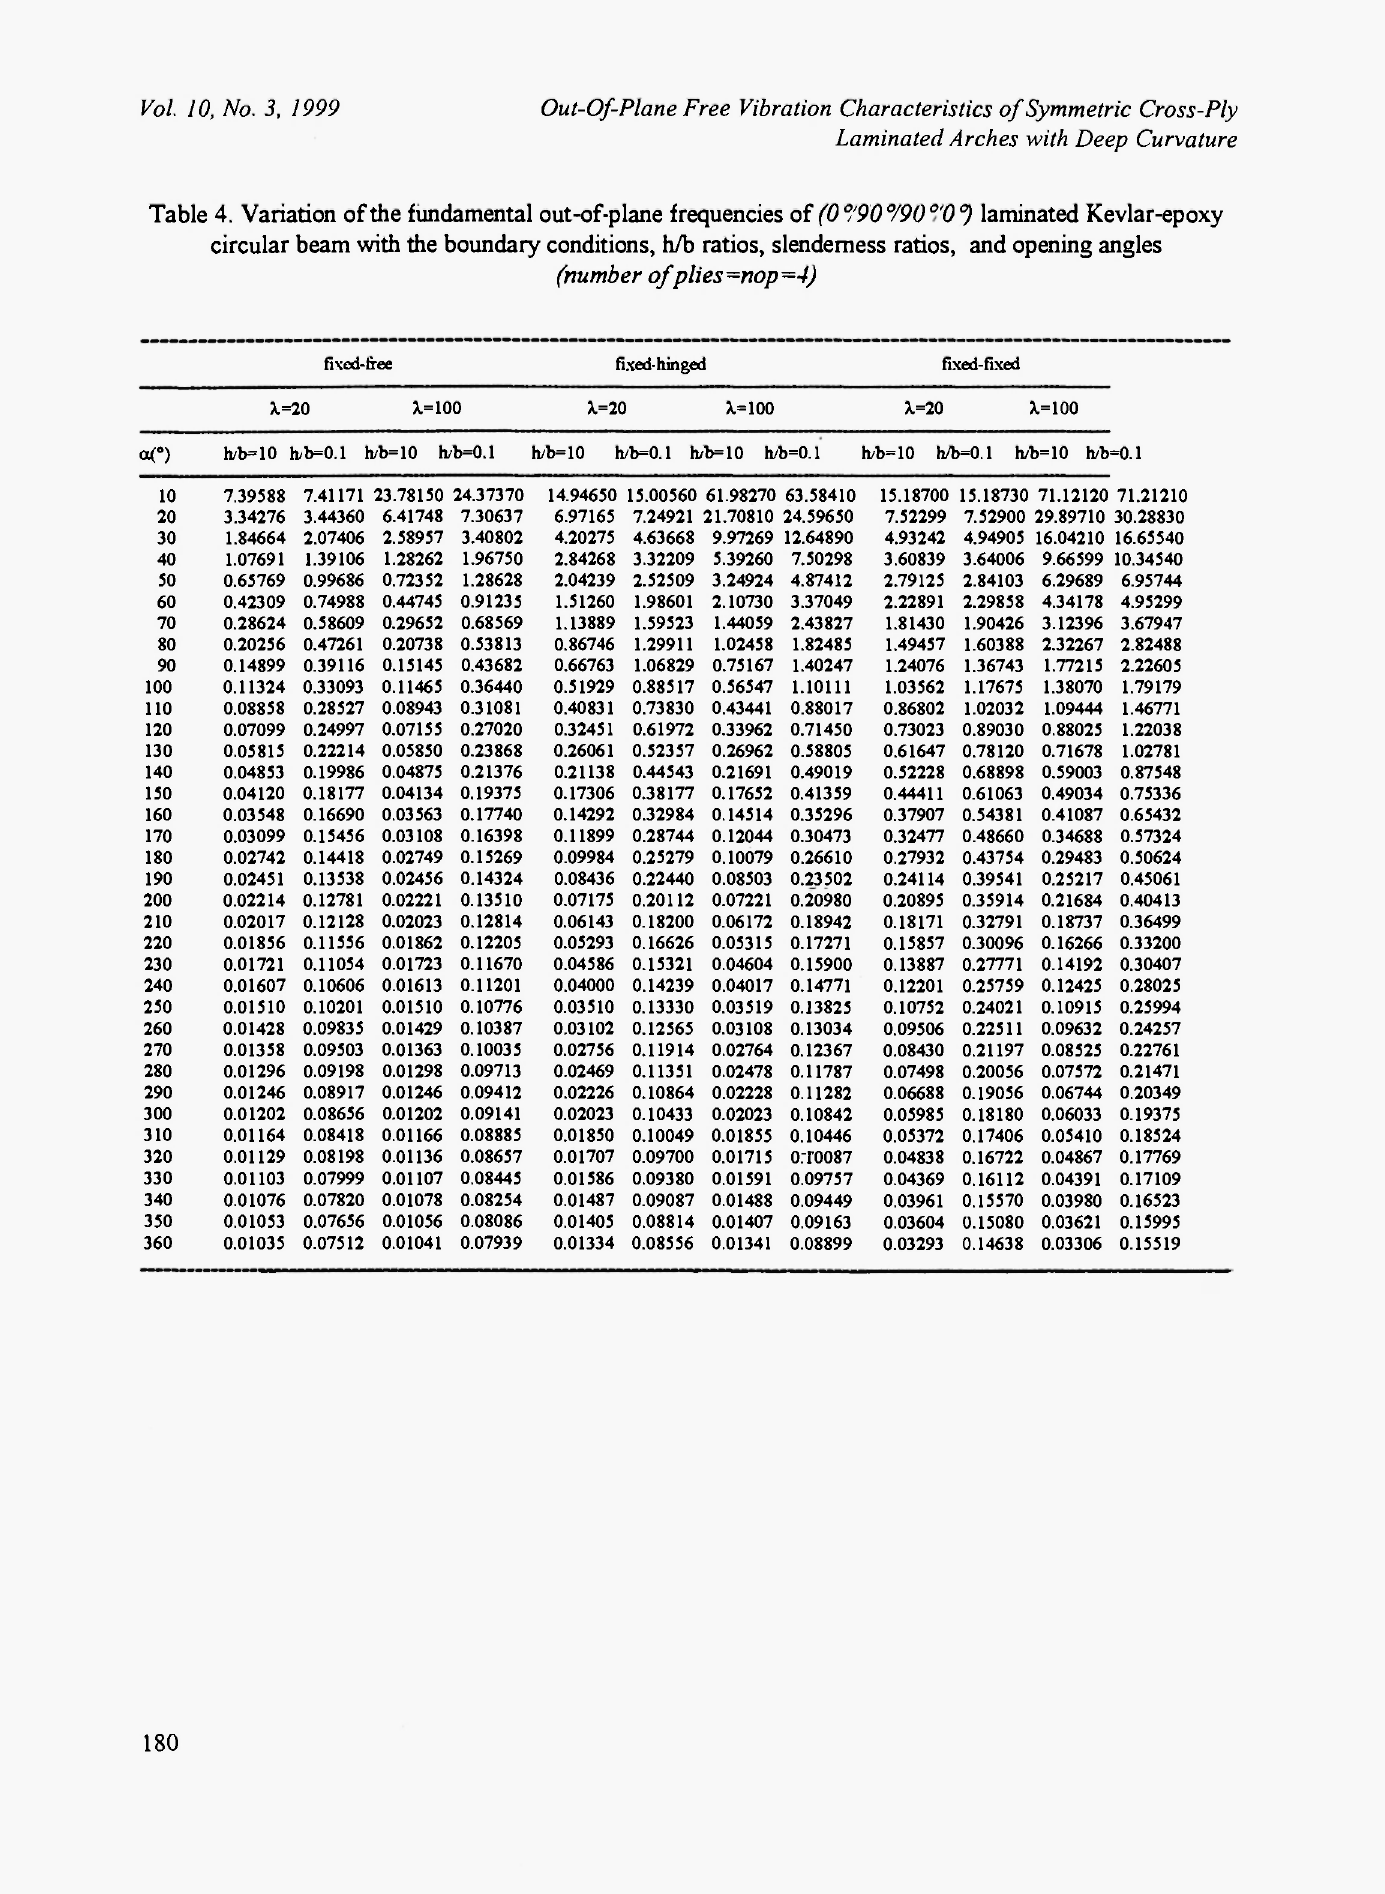
Table 4. Variation of the fundamental out-of-plane frequencies of (0°/90 ο /90°'0°) laminated Kevlar-epoxy circular beam with the boundary conditions, h/b ratios, slendemess ratios, and opening angles (number of plies